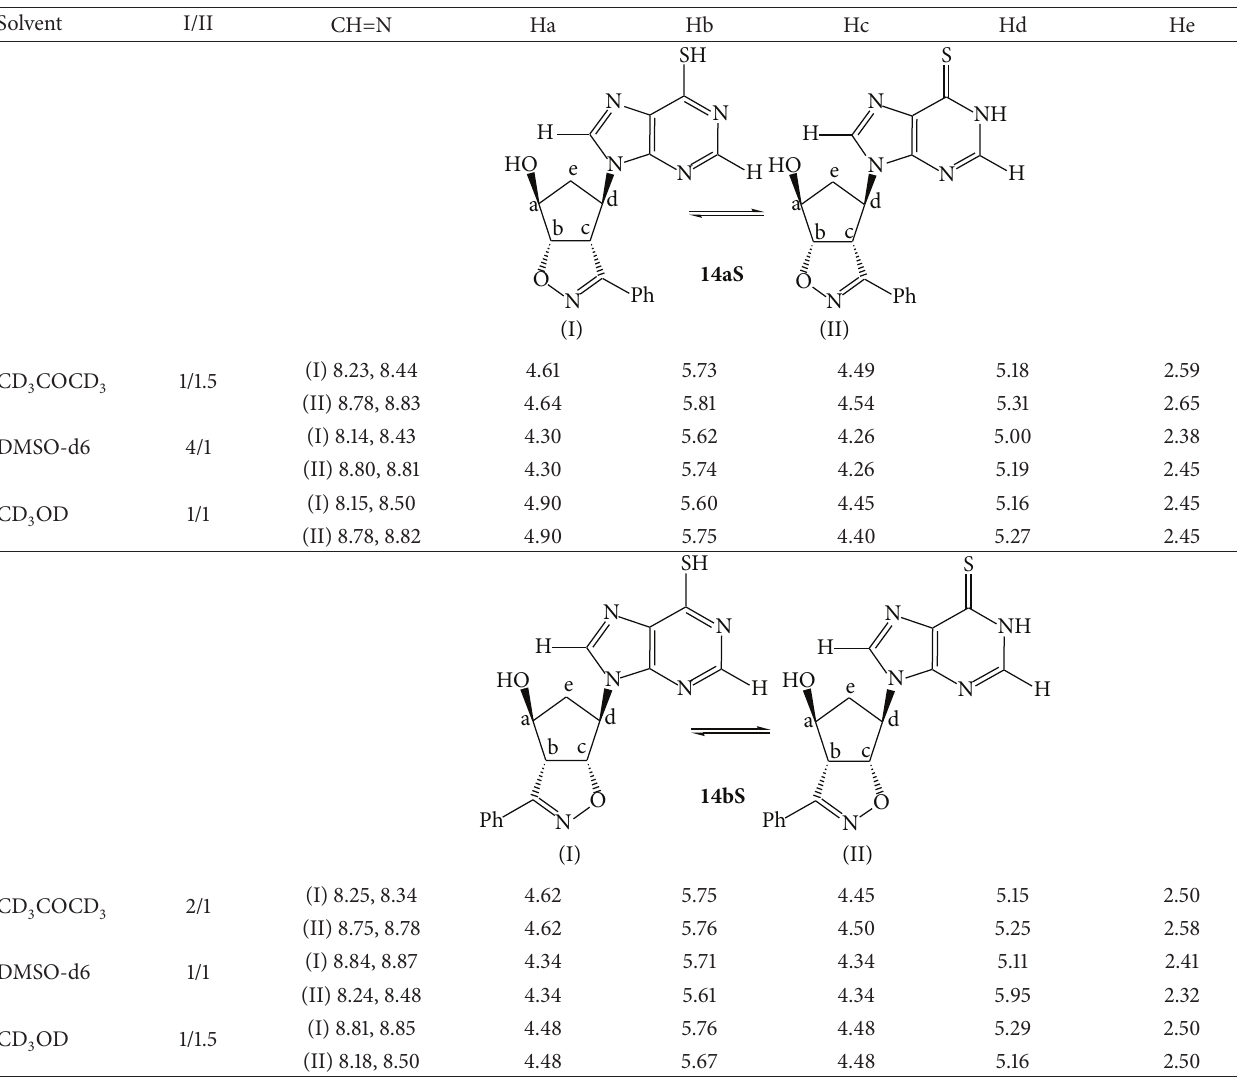
Table 1: Tautomeric ratios and chemical shifts for compounds 14a,bS